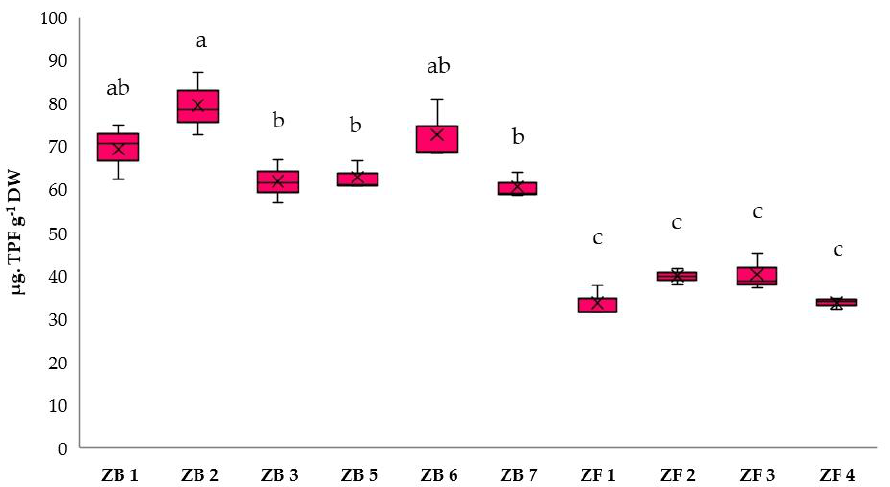
Figure 6. Dehydrogenase activity expressed as µg TPF g −1 DW. Results followed by the same case letter (a-c) are not significantly different according to Tukey’s HSD post hoc test ( p > 0.05).